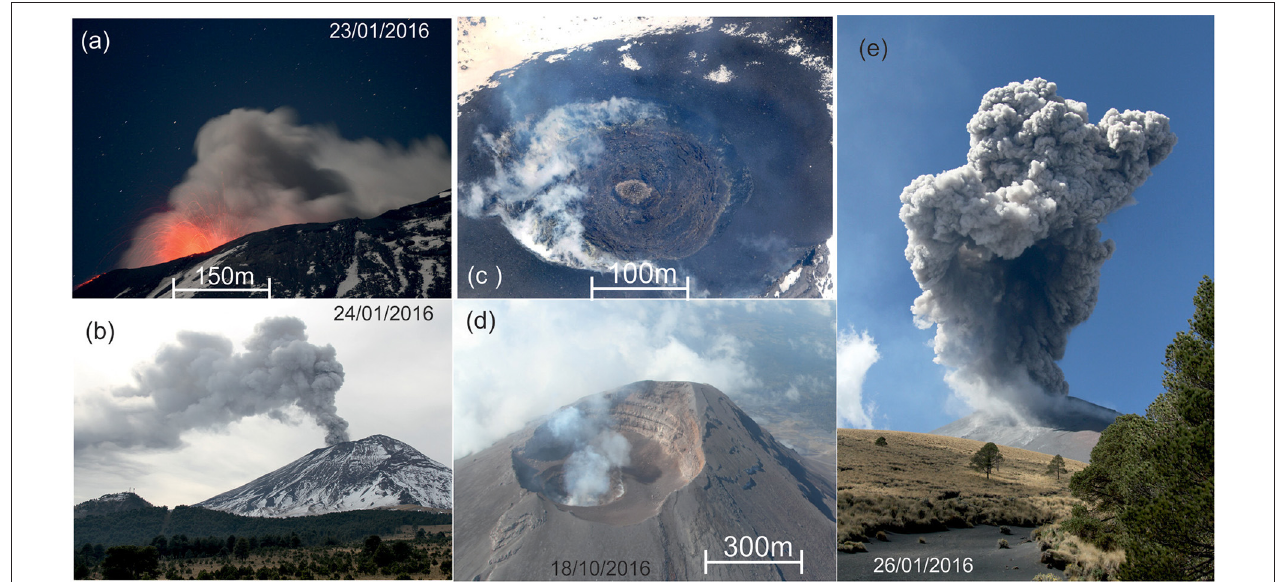
FIGURE 2 | Typical styles of activity occurring at Popocatépetl Volcano. (a) Weakly explosive activity and (b) continuous ash emission associated to the construction of a lava dome. (c) Lava dome filling the crater and degassing passively. (d) Passive Degassing without a lava dome. (e) Vulcanian explosion associated to dome destruction. All photos by R.C. except (c) by Ramon